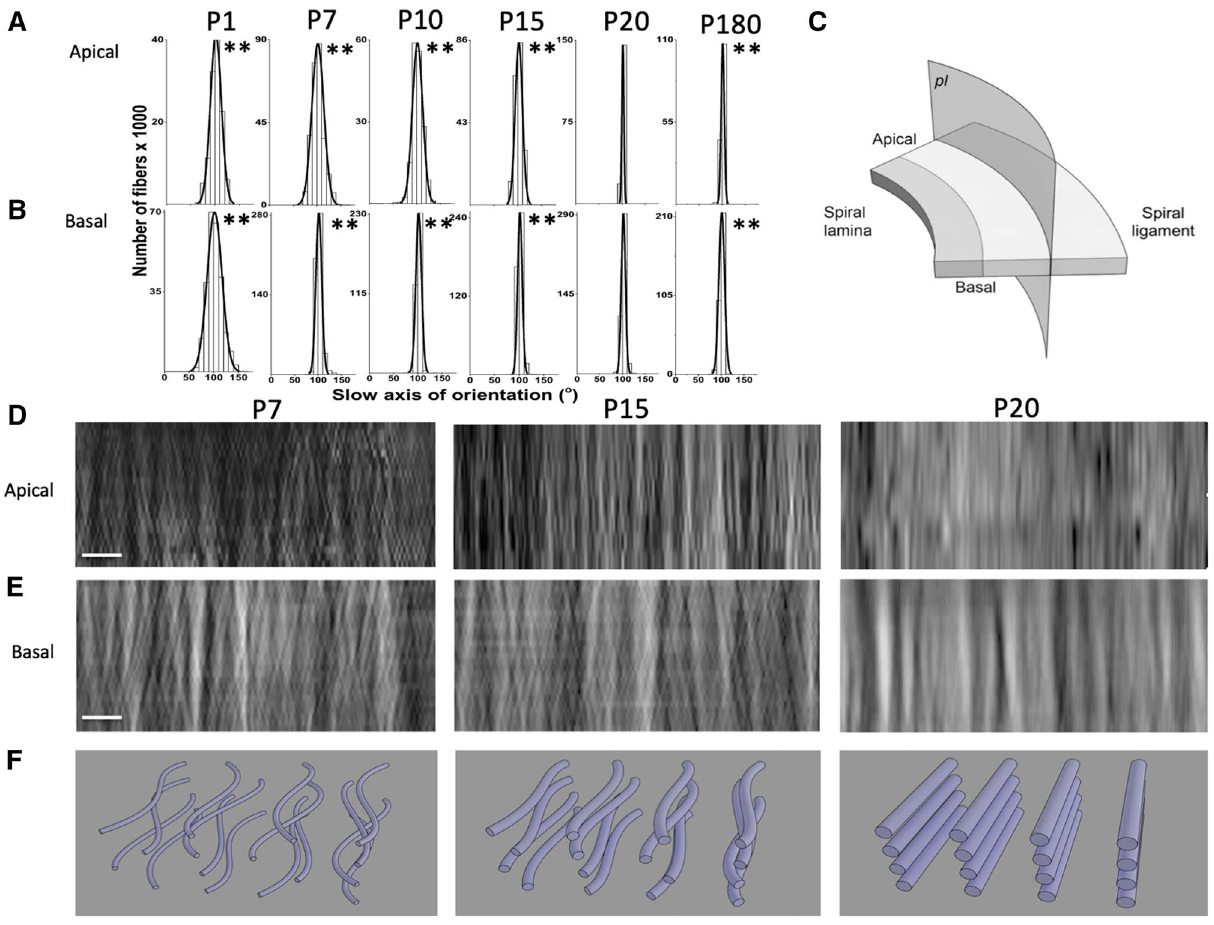
Figure 3. BM fibers become more narrowly orientated with increased alignment and decreased twisting with advancing development. ( A , B ) Histograms of BM fiber orientation as function of developmental stage (P1 to P180 for measurements in the apical ( A ) and basal ( B ) cochlea regions. Fiber orientations were assigned to 10° bins. The mean orientation in each preparation was normalized (to ~ 101°) and the resultant histograms were fitted with normal distribution curves. Table 1 lists SD from the mean. Groups, three mice (six cochleae); differences in SD, ** p < 0.0001, F test statistics. Fiber orientations for the apical turn were measured from optical sections (0.5 μm apart in 8 optical sections). Measurement numbers for each developmental age: P1 n = 35,693 ; P7 n = 17,064 ; P10 n = 90,001; P15 n = 193,020 ; P20 n = 163,805 ; P180 n = 166,203, using BM samples from six cochleae (3 mice) per age group. Fiber orientations measured for the basal turn were measured from optical sections (0.5 μm apart in 20 optical sections). Measurement numbers for each developmental age: P1 n = 261,740; P7 n = 417,994; P10 n = 283,742; P15 n = 365,359; P20 n = 145,339; P180 n = 147,231, using BM samples from six cochleae (3 mice) per age group. ( C , D ) Birefringent images constructed from optical stacks of transverse sections taken through the pectinate zone of the BM have a more homogeneous and less braded appearance with increasing stages of development. ( C ) Schematic diagram illustrating the plane of optical sections represented in ( D and E ). ( D ) Transverse (plane pl in C ) filament array images reconstructed from apical stacks of pectinate zone optical sections for P2, P7, P10, P15, P20 and P60 (0.5 μm apart; 8 apical and 18 middle optical sections; total thicknesses 4 μm, respectively). Scale bar 1 μm. E. Transverse (plane pl in C ) filament array images reconstructed from basal stacks of pectinate zone optical sections for P2, P7, P10, P15, P20 and P60 (0.5 μm apart; 18 basal optical sections; total thicknesses 9 μm, respectively). Scale bar 5 μm. ( F ) Schematic diagrams of the alignment and curvature of the BM fibers at P7, P15 and P20 that would account for the increased homogeneity in birefringence and decreased degree of braiding with advancing development seen in the optical sections shown in C and D. See Supplementary Fig. 3 for a video fibers become more aligned. The images shown in Fig. 3D,E represent a unique structure of extracellular matrix (ECM) in the BM which, in its mature form, looks like an alignment of flat sheets of extracellular matrix that run perpendicular to the length of the BM. A schematic representation summarizing the main observations of BM structural development is shown in Fig. 3F and Supplementary movie. Together, these results provided evidence that the collagenous fibers become more compact and tightly aligned as development progressed, and that the alignment of fibers was preserved through the length of the BM 43 . This is the first study which demonstrates the developmental changes in 3D BM structure. The mature